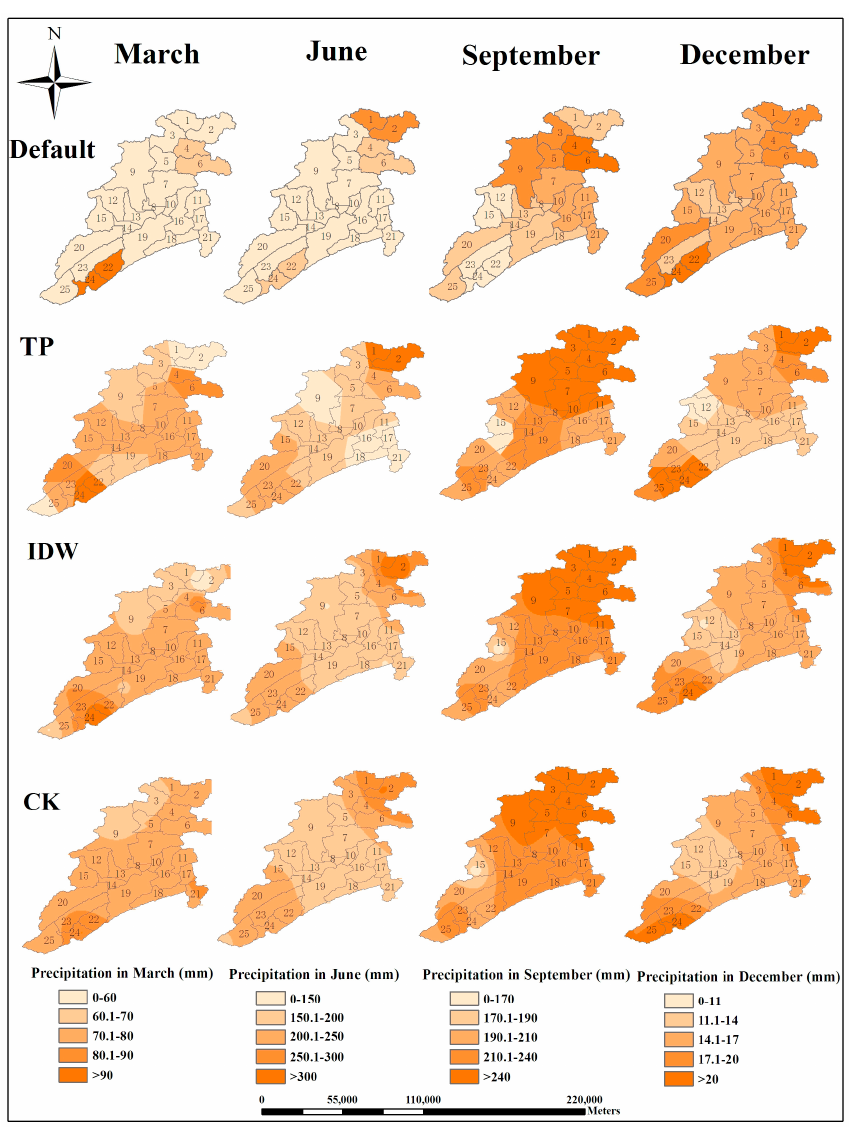
Figure 2. Mean monthly rainfall maps by TP (the first row), IDW (the second row) and CK (the third row) in March, June, September and December from 2009 to 2013. TP is abbreviation of Thissen Polygen; IDW is abbreviation of Inverse Distance Weighting; CK is abbreviation of Co-Kriging.